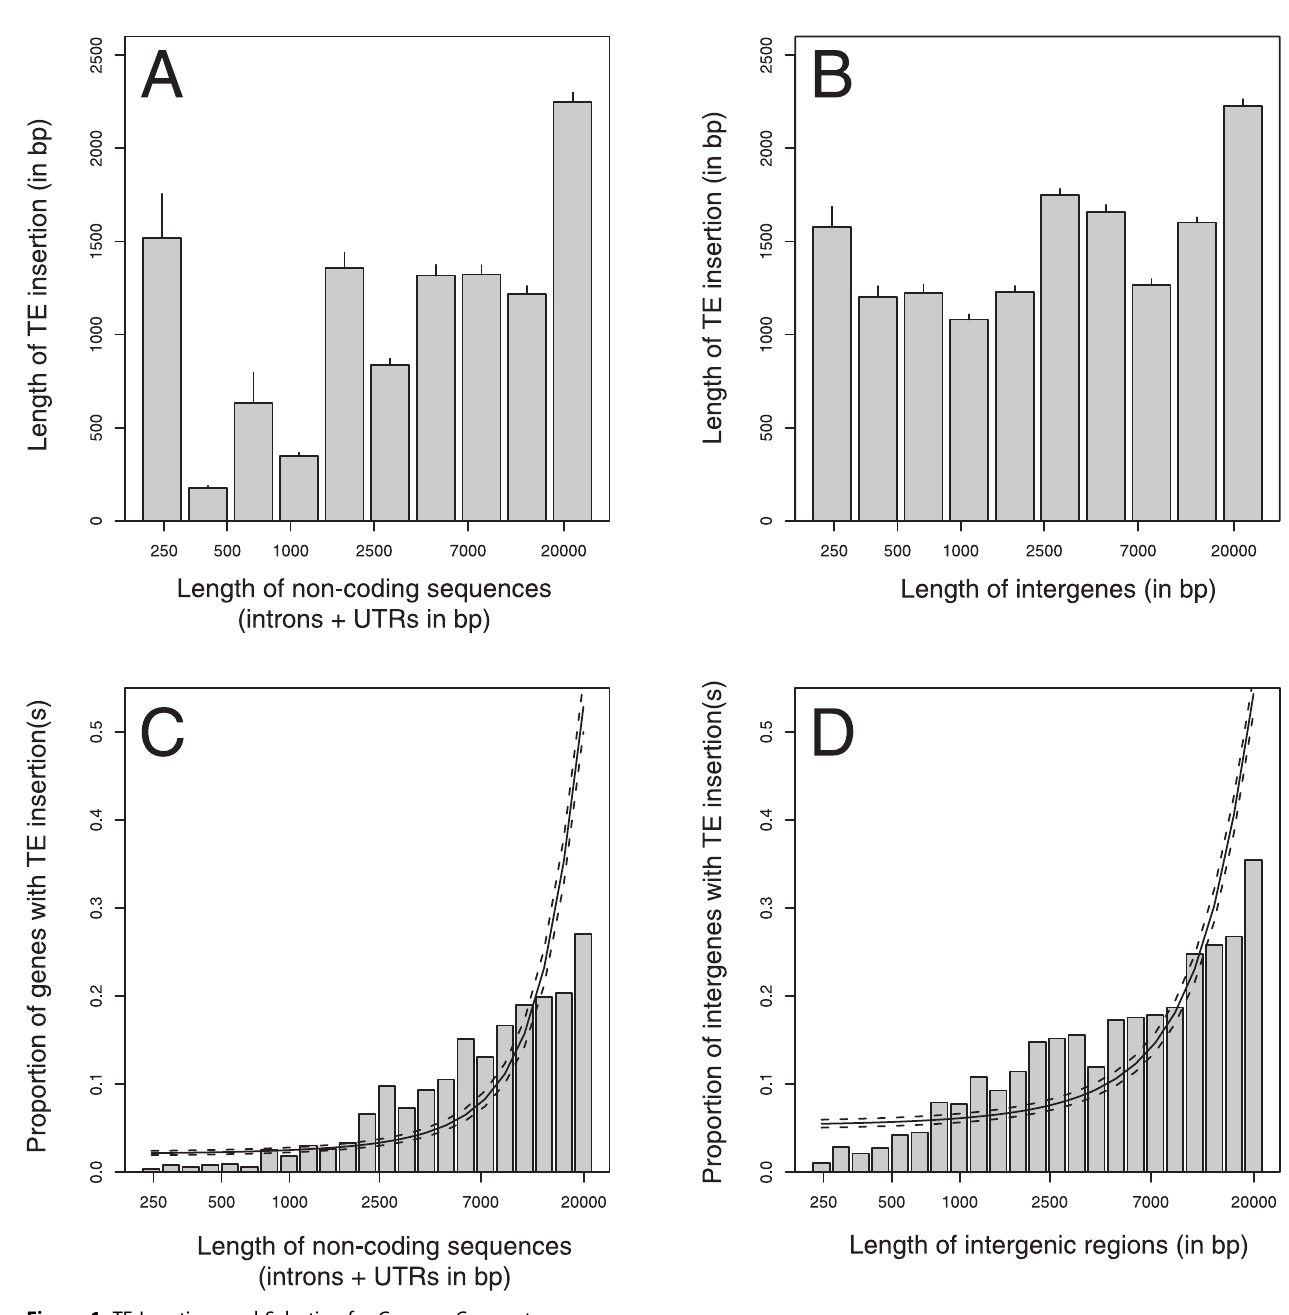
Figure 1. TE Insertions and Selection for Genome Compactness (A,B) The correlation between the length of noncoding sequences and the length of TE insertions for genes and intergenic regions. To avoid interaction or facilitation effects in the case of multiple insertions, only unique insertions (by gene or intergenic region) were incorporated in this analysis. (C,D) The nonlinear relationship between the length of noncoding sequences and the proportion of genes or intergenic regions with TE insertion(s). The lines represent the linear model (estimate and standard error) for this correlation (quasibinomial GLM on presence/absence of insertion[s] in genes and intergenic regions).